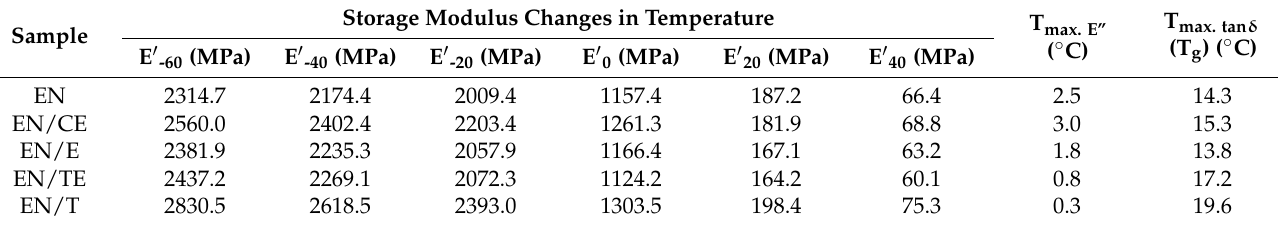
Table 3. Additional data regarding the changes in temperature properties for unimpregnated and impregnated ethylene– norbornene copolymer samples and the temperature values assigned to the maxima observed for loss modulus and damping factor; T max E” —temperature at which the maximum of loss modulus is detected, T max tan δ —temperature at which the maximum of damping factor is